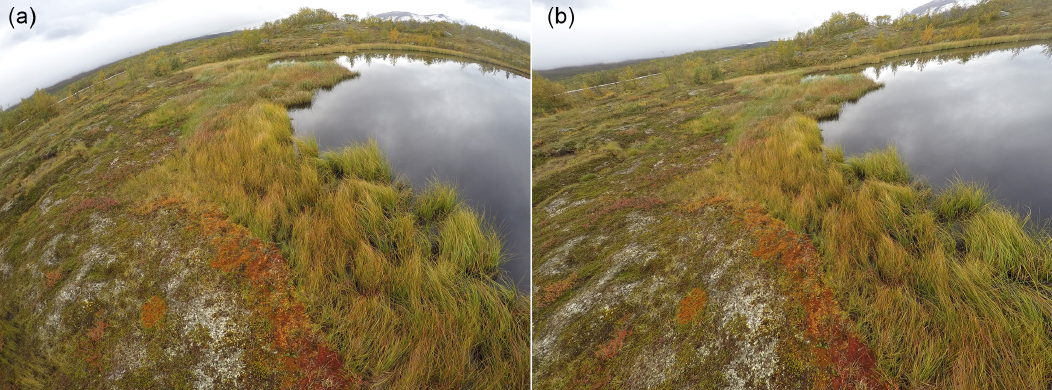
Figure 2. Correction of lens distortion. (a) Raw wide-field camera image. (b) After